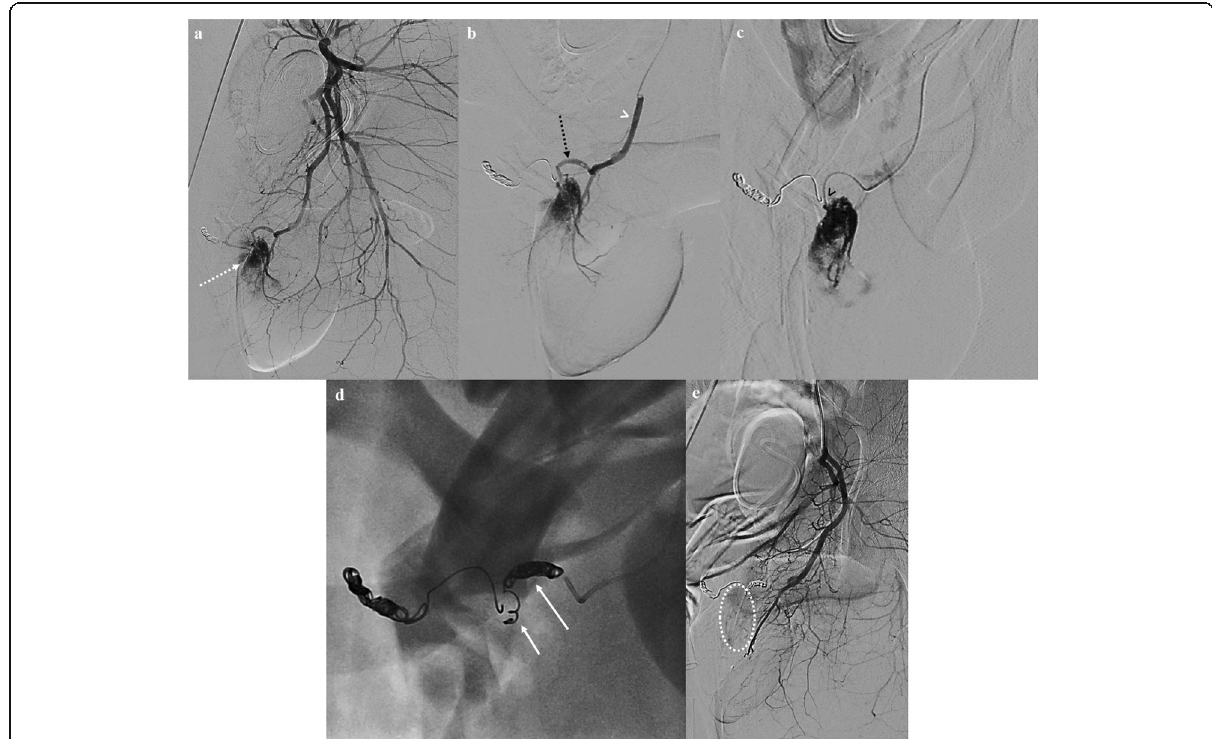
Fig. 4 Angiography, second procedural time: diagnostic angiography and endovascular embolization of right pudendal branches ( a ) DSA of left hypogastric artery branches showing vascular injury (discontinued white arrow) at the penis root supplied by a distal division branch of the left internal pudendal artery (discontinued white arrow); ( b ) DSA with microcatheter ’ s tip at internal pudendal artery (head of white arrow) showing urethral-bulb branch (discontinued black arrow) with contrast agent extravasation; ( c ) microcatheter ’ s tip is positioned as closer as possible to the vascular injury (head of black arrow); ( d ) fluoroscopy showing released micro-coils (white arrows); ( e ) DSA of the anterior branch of hypogastric artery showing successful embolization and presence of physiological «cavernosal blush» (discontinued white